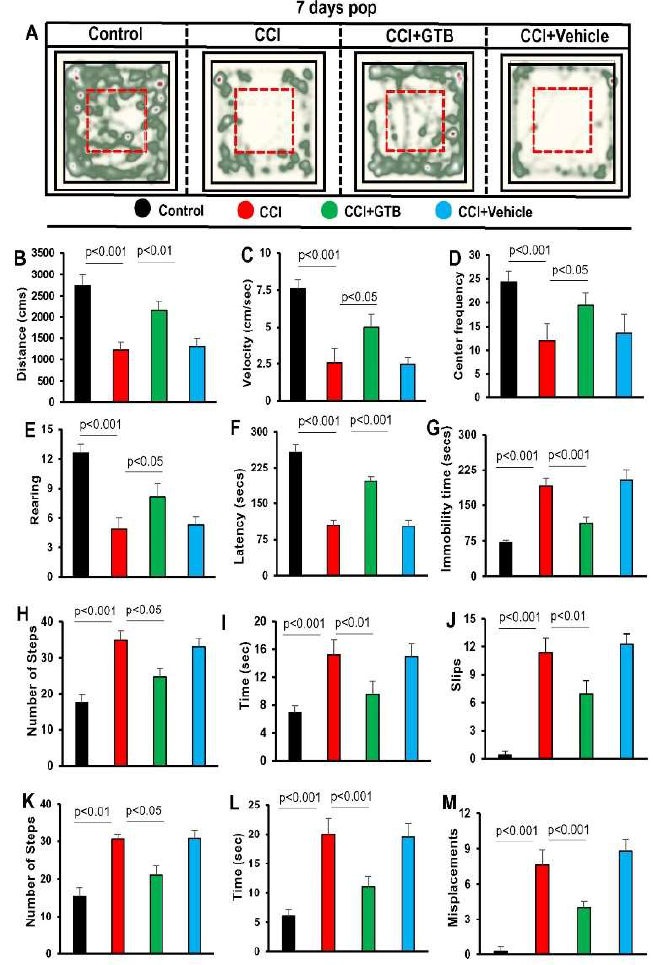
Figure 6. GTB treatment recovers motor functions in TBI mice. TBI was induced in mice by CCI injury and after 24 h of injury, mice were treated with 50 mg/kg/day of GTB via oral gavage. Seven days after CCI injury, mice were tested for open field behavior (( A ), heat map analysis monitored by using the Noldus system; ( B ), distance moved; ( C ), velocity; ( D ), center frequency; ( E ), rearing), rotorod (( F ), latency), tail suspension test (( G ), immobility time), beam walking (( H ), number of steps; ( I ), time taken; ( J ), slips), and grid runway (( K ), number of steps; ( L ), time taken; ( M ), misplacements). Six mice were used in each group. Statistical analyses were performed by one-way ANOVA followed by Tukey’s post hoc test.